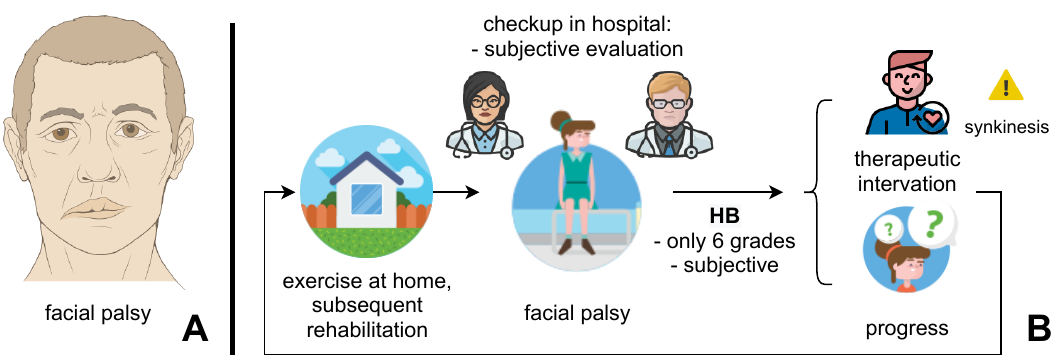
Figure 1. ( A ) illustrates facial palsy. Note the difference between the left (sick) and right (health) parts of the face. Image source [22]. ( B ) ilustrates problems with clinical classifications, e.g., House–Brackmann classification is observer dependent with six grades